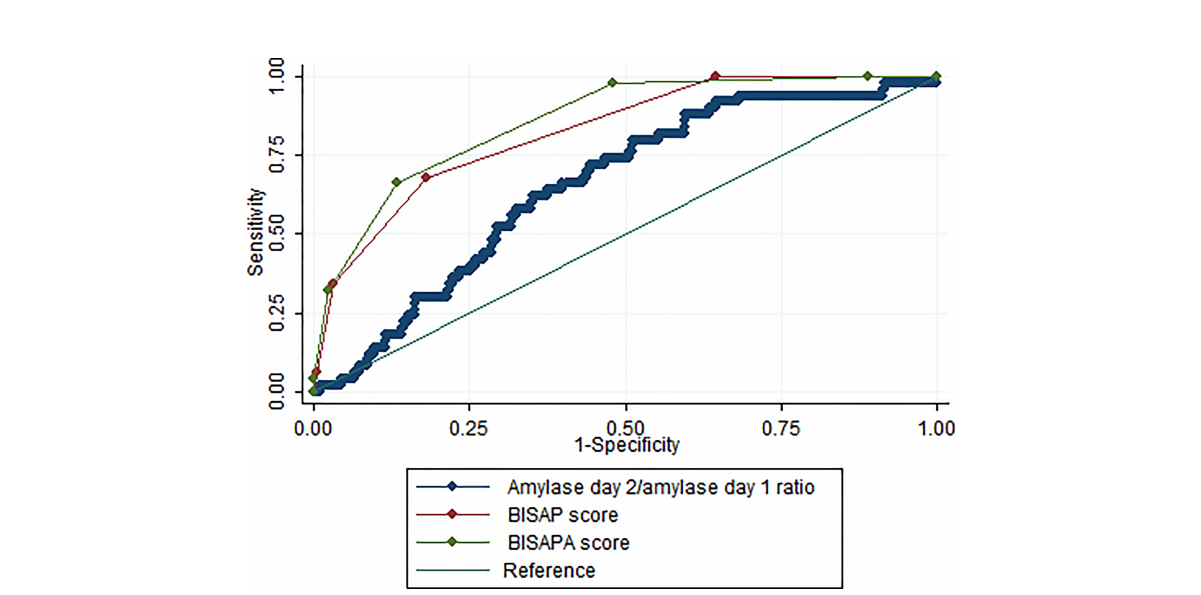
FIGURE 3 The ROC curves for serum amylase day 2/amylase day 1 ratio, BISAP score, and BISAPA score for SAP prediction. BISAP, bedside index of severity in AP; SAP, severe acute pancreatitis; BISAPA, bedside index of severity in acute pancreatitis and amylase day 2/amylase day 1